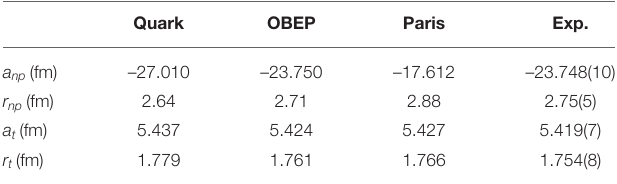
TABLE 2 | Low-energy scattering parameters from Entem et al. [ 52].